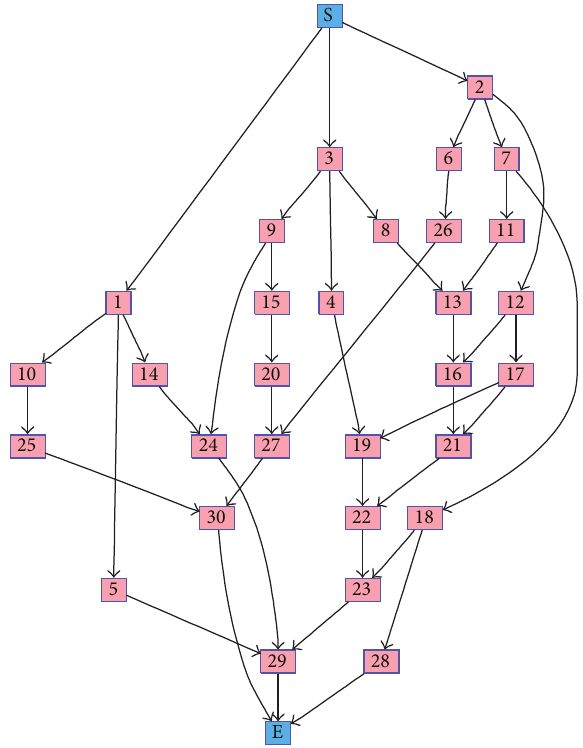
Figure 1: Original task precedence